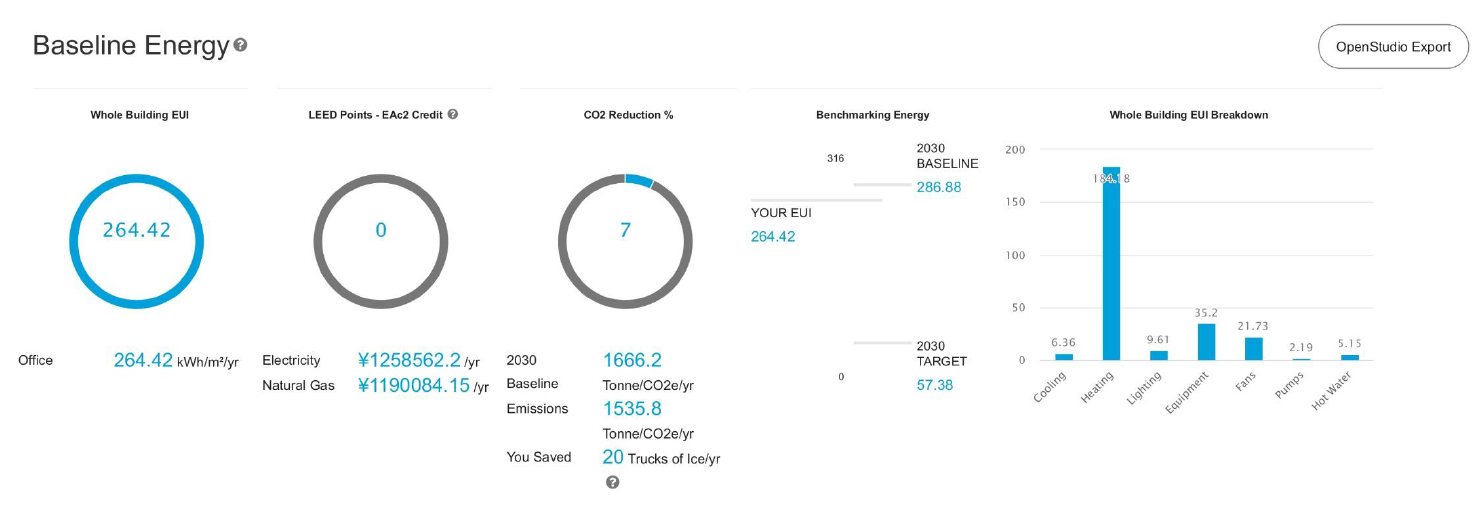
Figure A15. Zone 4- A Xi’an, Shaanxi (post-COVID-19 84% scenario). Figure A15. Zone 4-A Xi’an, Shaanxi (post-COVID-19 84% scenario).